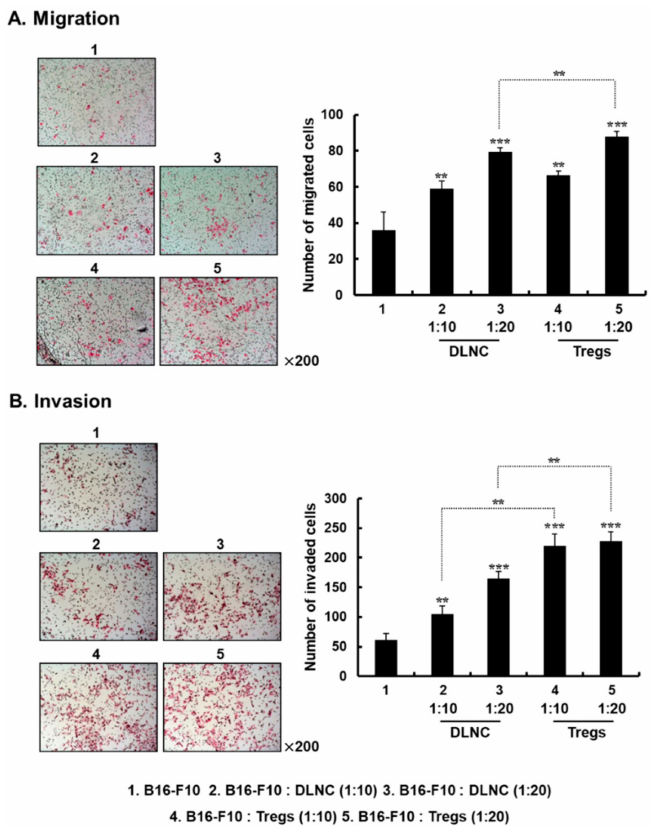
Figure 1. E ff ect of regulatory T cells (Tregs) on the migration and invasion of B16-F10 cells. Cell migration ( A ) and invasion ( B ) assays were conducted using a modified transwell migration chamber. After B16-F10 cells were co-cultured with draining lymph node cells (DLNC) or Tregs at various co-culture ratios, cancer cells were placed on the filter membrane in the top chamber. Cells that had migrated or invaded to the lower filter surface were stained with hematoxylin and eosin (H & E). Images are representative of results from three independent experiments performed in triplicates. Original magnification: × 200. Cells that had migrated or invaded were counted in three randomly selected fields from three independent wells for each experimental group. Data are shown as mean ± standard deviation (SD) of results from three independent fields / well. Figure 1A: ** p < 0.01 or *** p < 0.001 versus B16-F10 group, and ** p < 0.01 for B16-F10: DLNC versus B16-F10: Tregs (1:20). Figure 1B: ** p < 0.01 or *** p < 0.001 versus B16-F10 group, and ** p < 0.01 for B16-F10: DLNC (1:10) versus B16-F10: Tregs (1:10) and B16-F10: DLNC (1:20) versus B16-F10: Tregs